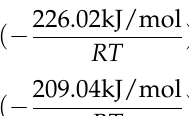
Figure 3. Temperature dependencies of kinetics constants k FeB and k Fe 2 B Arrhenius relationships ( a ): FeB and ( b ): Fe 2 B .